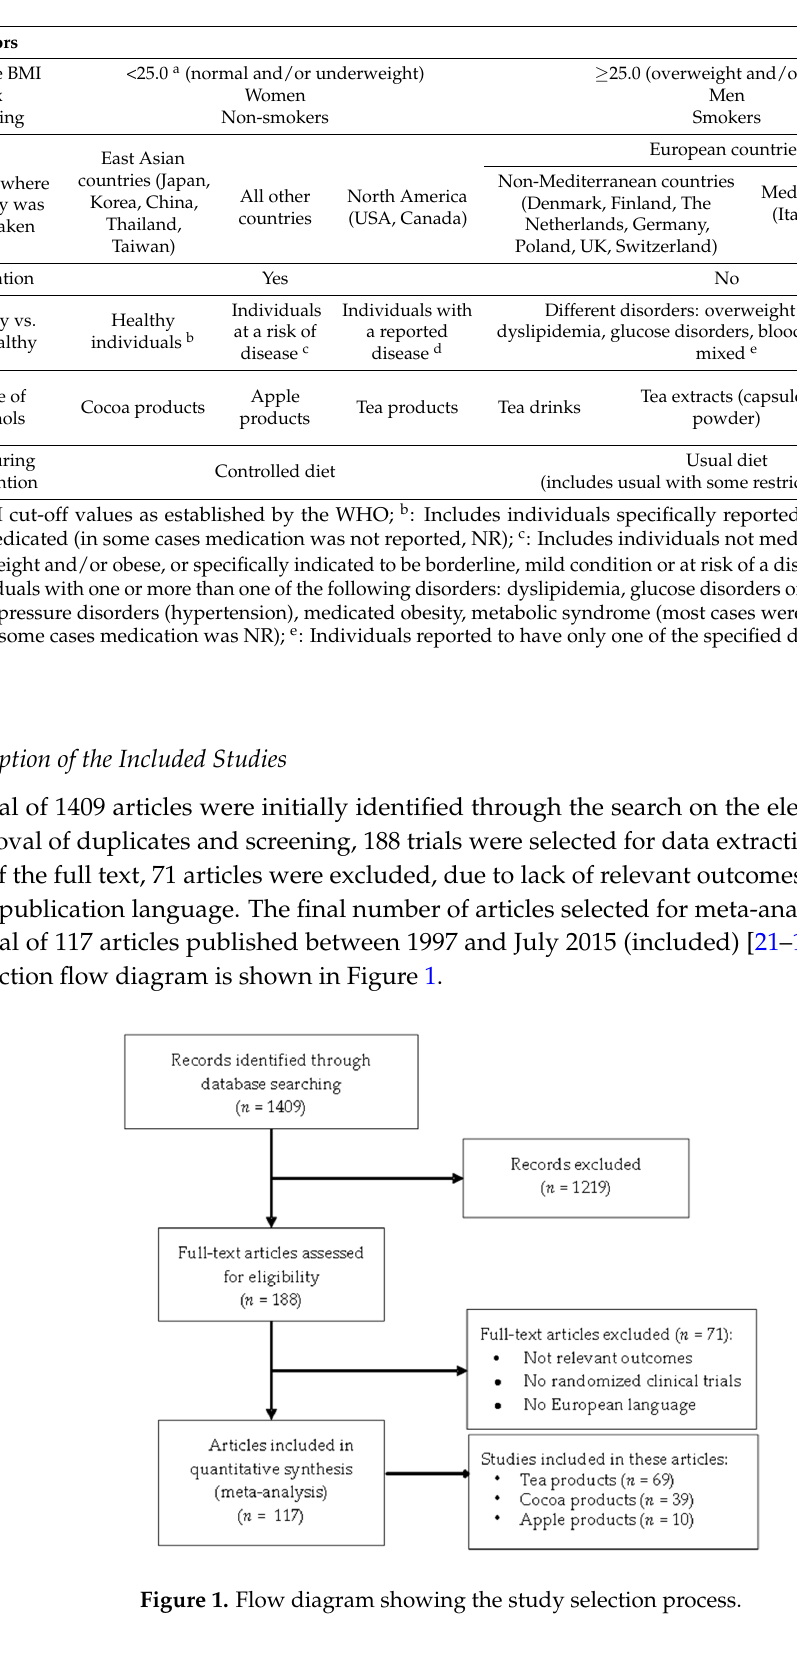
Table 1. Potential factors influencing the heterogeneity in the responses to the supplementation with flavanols-containing products investigated in this meta-analysis.